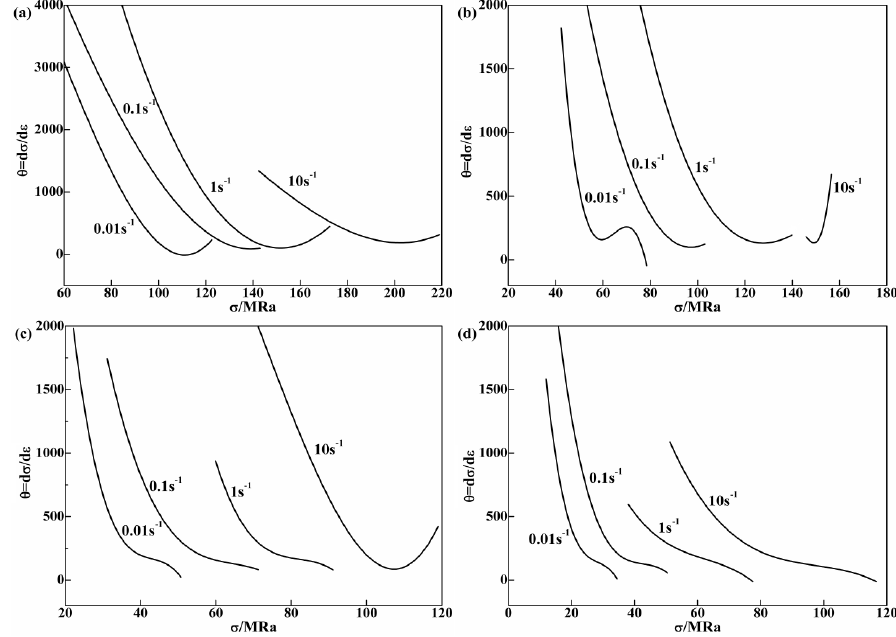
Figure 8. Curves of θ versus σ for 35CrMo steel under different deformation temperatures: ( a ) 850 °C,